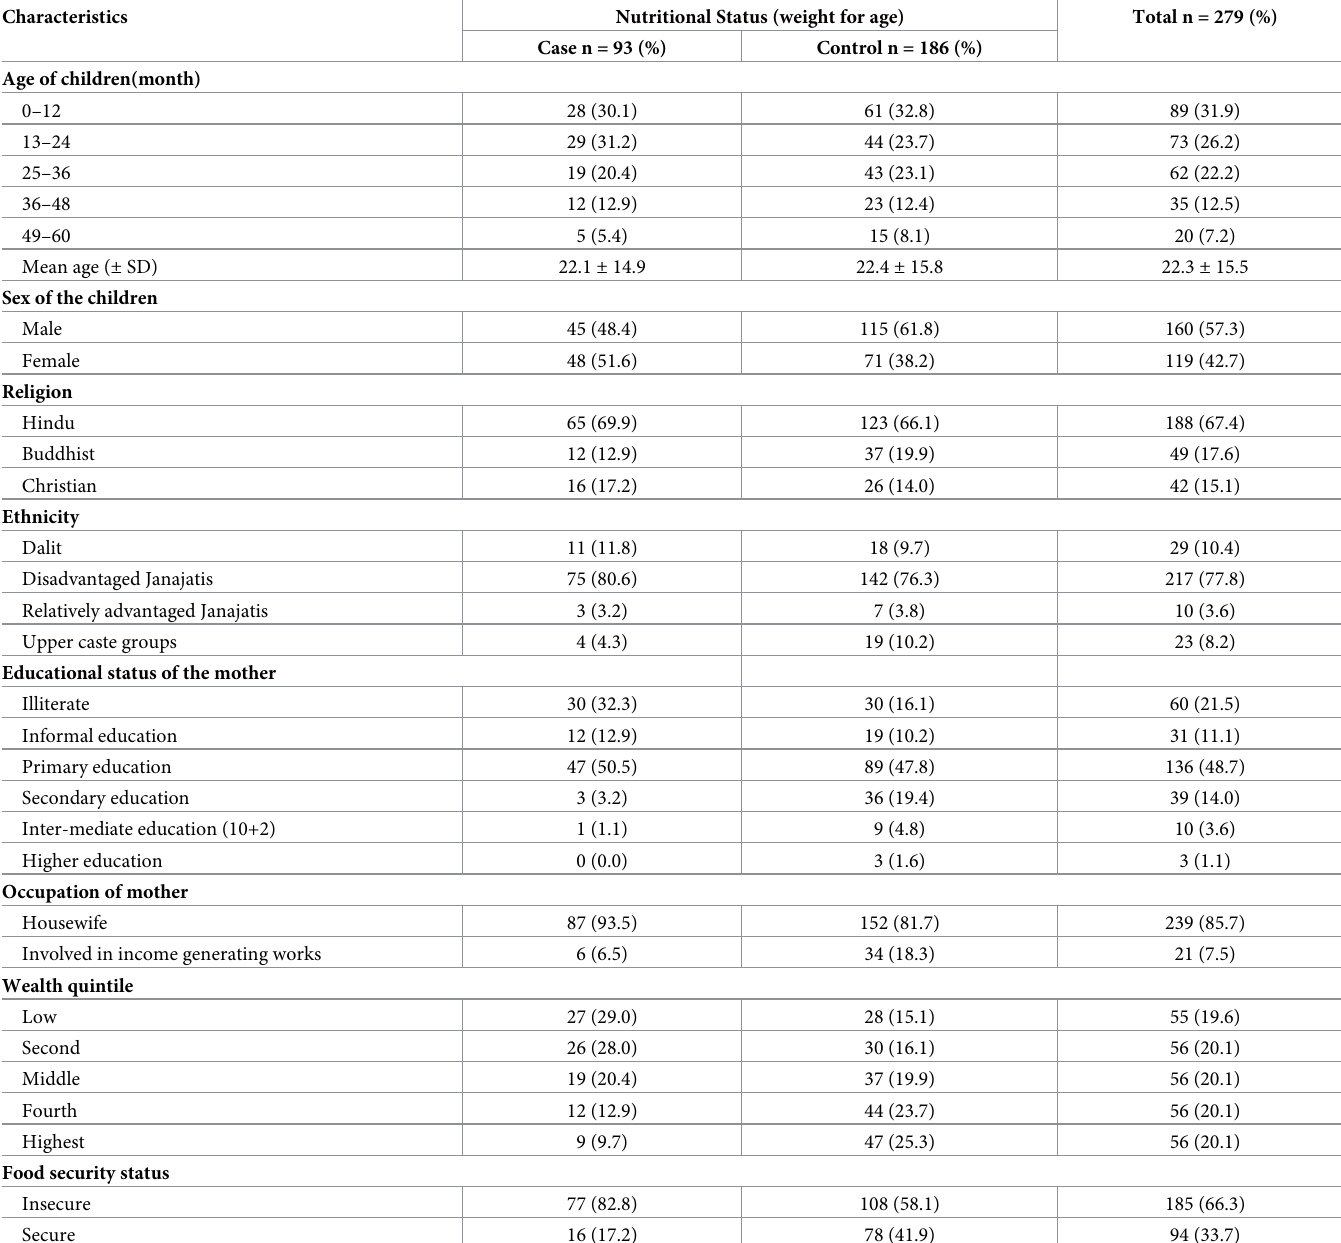
Table 2. Socio-demographic and economic characteristics of cases and